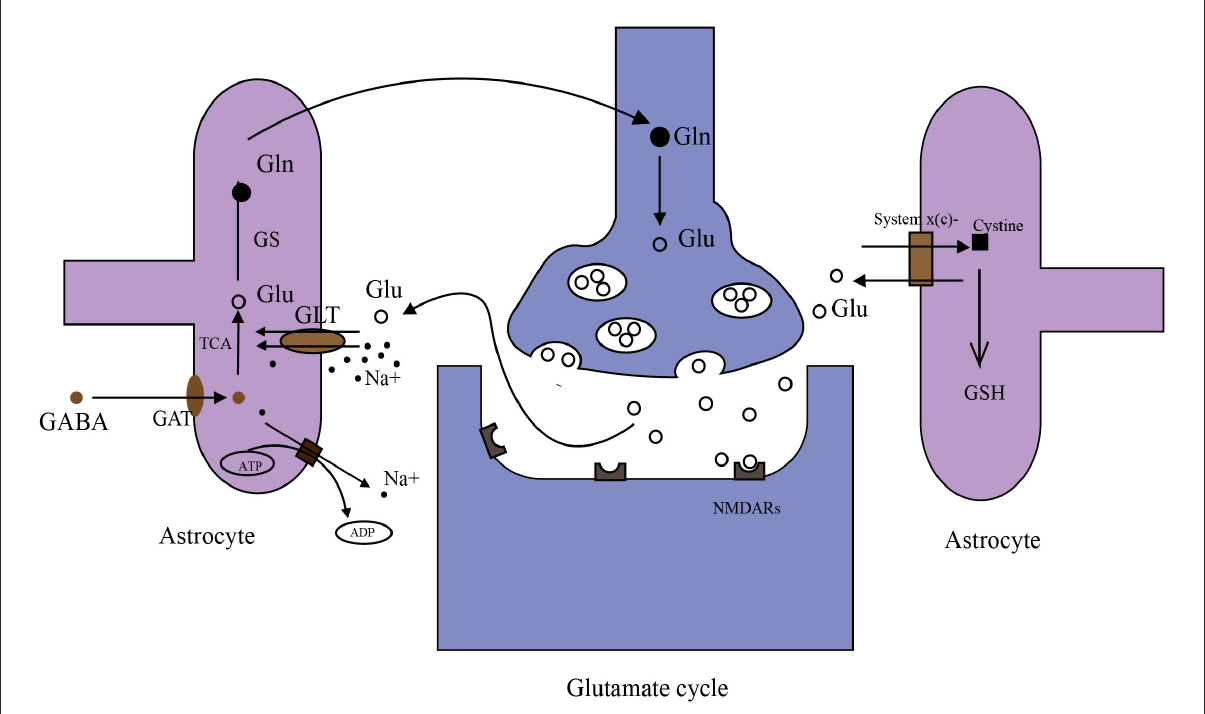
FIGURE2 Metabolism of glutamate in the brain. (1) Glutamate (Glu)–glutamine (Gln) cycle: when nerve impulses are transmitted to the postsynaptic membrane, the neurotransmitter glutamate (Glu) stored in synaptic vesicles is released into the synaptic cleft and binds with glutamate receptors (NMDARs). Glutamate transporters (GLT-1 shown in the figure) on astrocyte transport Glu together with Na + into astrocytes. Na + in astrocytes is transferred to extracellular by an ATP-dependent Na + pump. Glu in astrocytes is converted to Gln by GS, then Gln is taken up by synapses and converted to Glu in synapses. Glu is stored in synaptic vesicles again. (2) γ aminobutyric acid (GABA) is taken up by GABA transporters (GATs) in astrocytes. Then GABA can be converted to Glu through the tricarboxylic acid cycle (TAC). (3) System x(c)- transports cystine into cells in exchange for the Glu. Cystine synthesizes glutathione (GSH) in